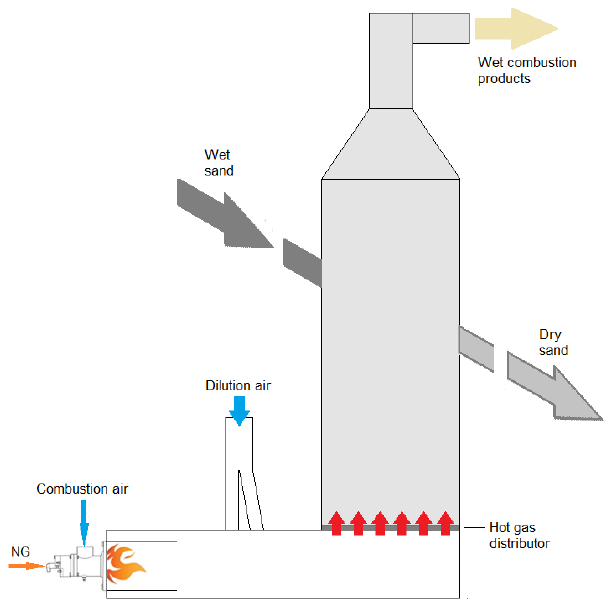
Figure 7. Enthalpy of combustion gases as function of temperature (T furnace = 1500 °C; SC = 1.10; T air = 1000 °C).